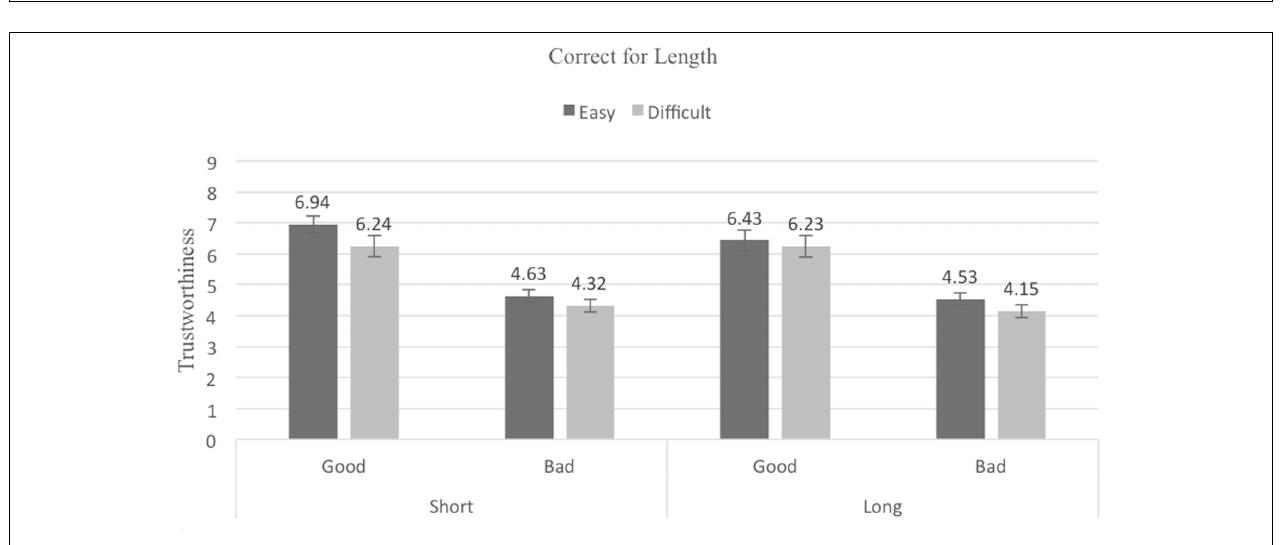
FIGURE 4 | Average trustworthiness ratings in the Pronounceability-correction condition of Experiment 4; error bars denote standard errors.